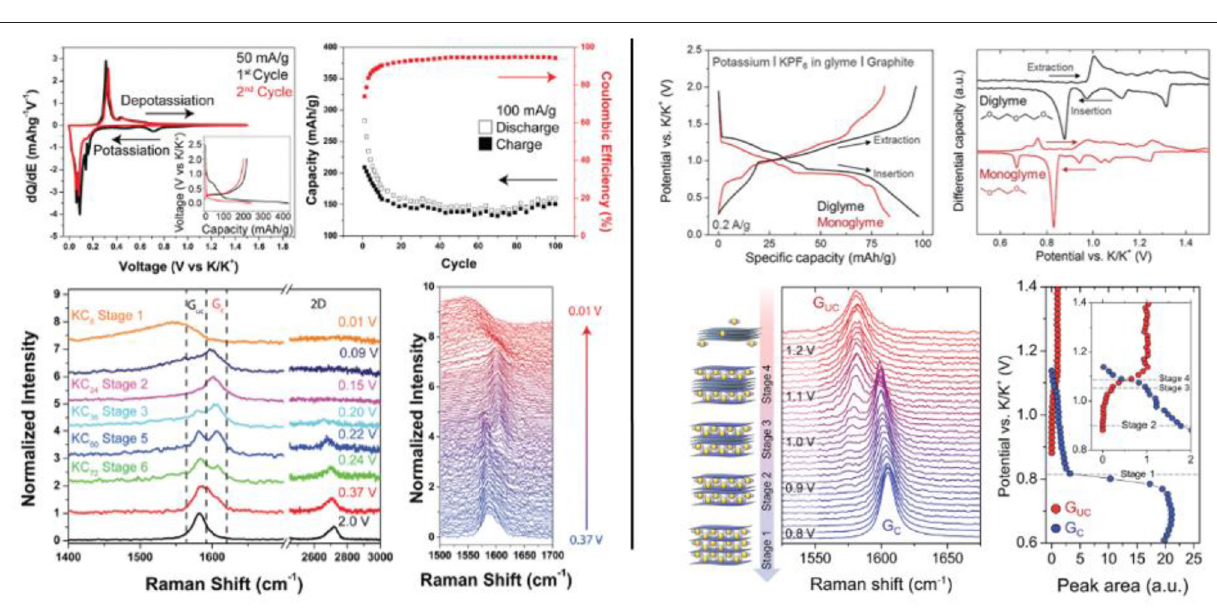
in DME gives rise to a thin SEI and a small expansion of the (002) graphite plane, whereas KPF 6 (1 M) in EC/DMC leads to the formation of KC 8 with 60% volume expansion and a thicker SEI (Wang et al.,